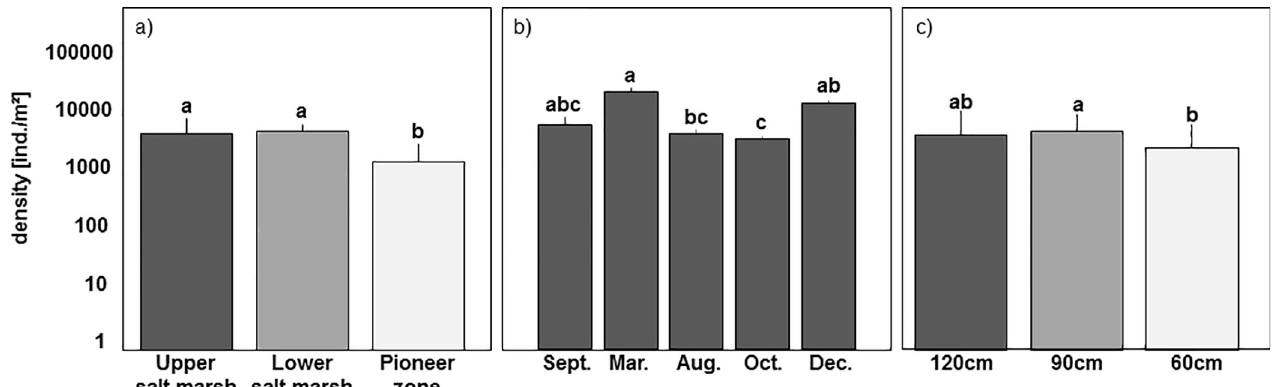
Fig 1. (a) Density (means+SD; note log-scale) of total oribatid mites (adults and juveniles) from the upper salt marsh, lower salt marsh and pioneer zone. (b) Density (means+SD; note log-scale) of total oribatid mites from all three vegetation zones at different sampling dates. (c) Density (means+SD; note log-scale) of total oribatid mites from the three artificial island heights (120, 90, 60